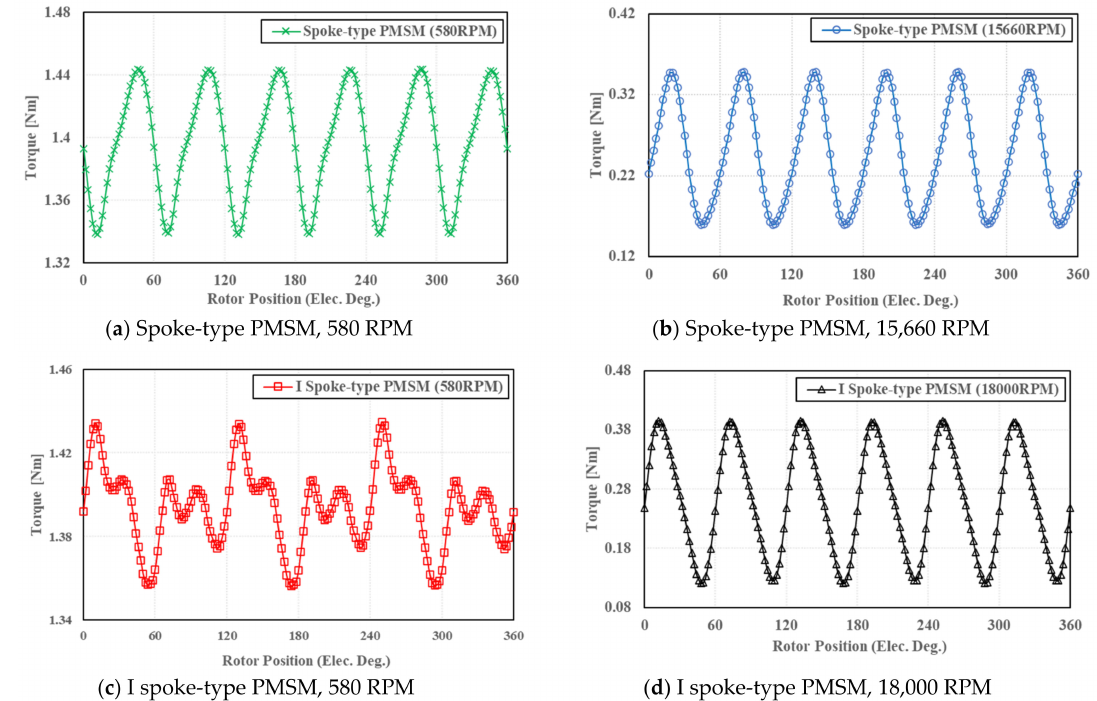
Figure 9. Torque ripple according to each operation of the two